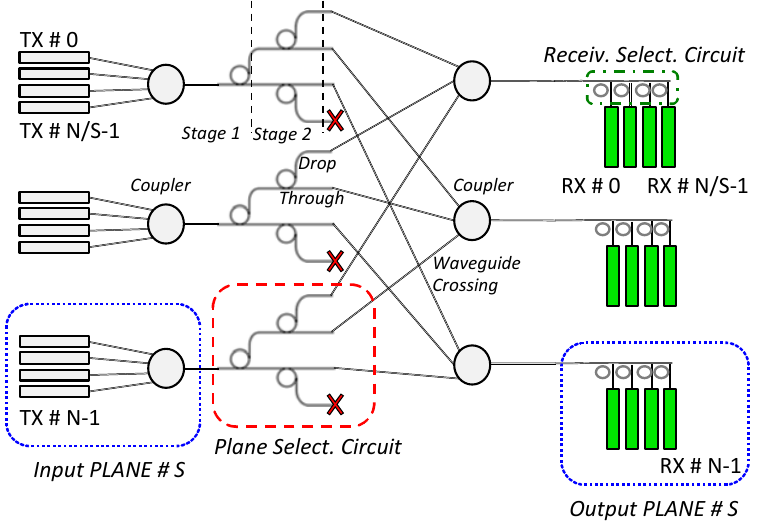
Figure 2. Ring Resonator-based switching